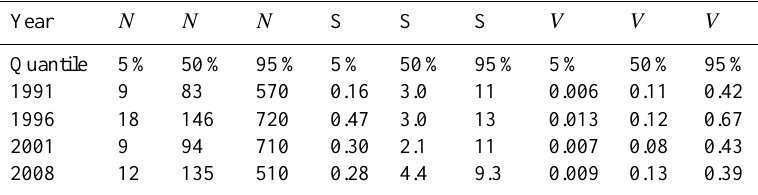
Table 2. 5%, 50%, and 95% percentiles of hourly averages of total number ( N , cm − 3 ), total surface (S,µm 2 cm − 3 ), and total volume ( V , µm 3 cm 3 ) concentrations for time periods listed in Table 1 of the Oden expeditions in 1991, 1996, 2001, and